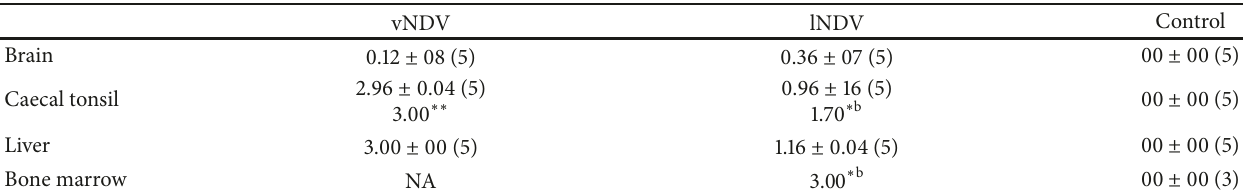
Table 11: Lesions scoring induced by velogenic and lentogenic NDV strains in HE stained brain, caecal tonsil, liver, and bone marrow tissues on day 5 pi.